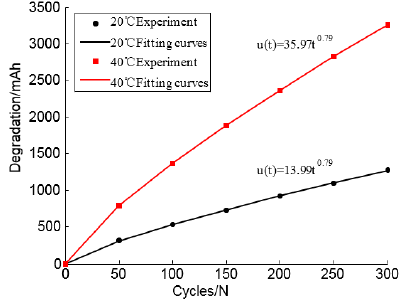
Figure 6. Recession parameter curves at different discharge rates. Figure 8. Current profiles of the battery for the Urban Dynamometer Driving Schedule (UDDS) test.